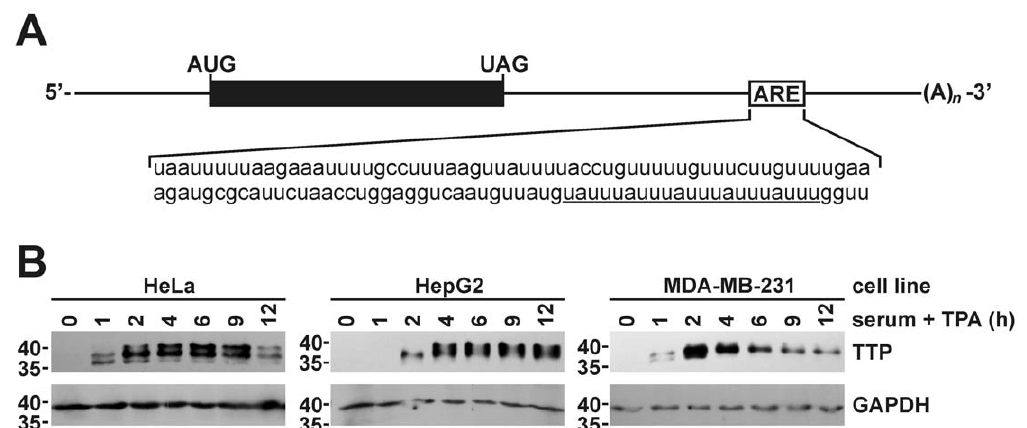
Figure 3. Induction of the ARE-binding protein TTP in mitogen-stimulated cancer cell lines. (A) Schematic of PIM1 mRNA showing a putative ARE sequence within the distal 3 9 UTR. Sequences corresponding to consensus TTP-binding sites are underlined. (B) Western blots showing the induction of TTP protein at selected times following mitogenic stimulation of cancer cell lines. Whole cell lysates were prepared at indicated time points following addition of serum + TPA to serum-starved cultures. GAPDH levels were used to normalize protein loading. The positions of molecular weight markers (in kDa) are indicated left of each blot.